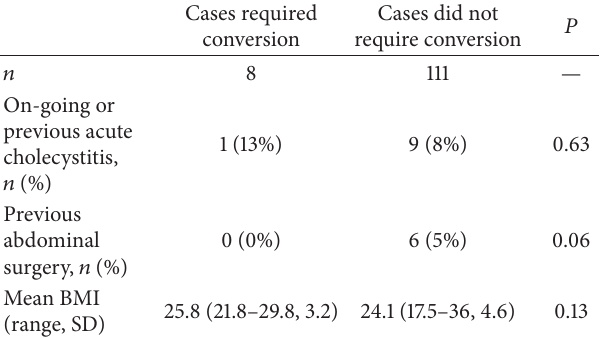
Table 3: Comparison of potential risk factors in cases with and without conversion.